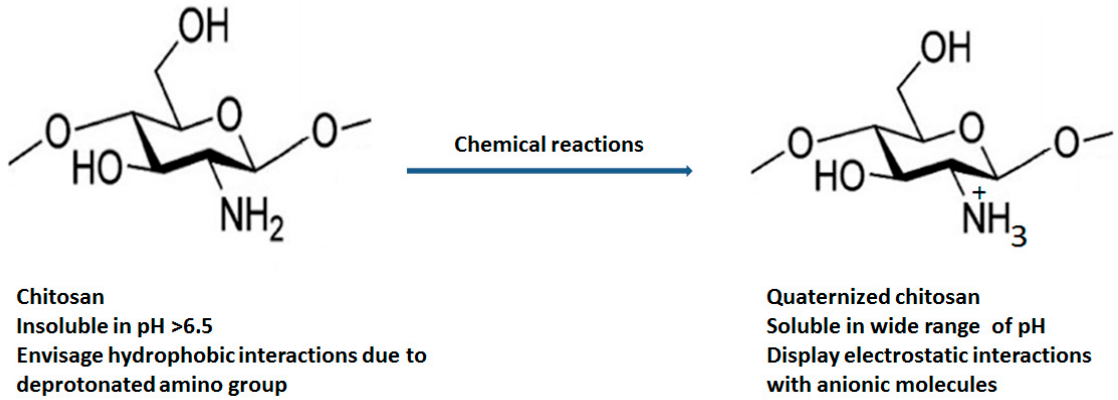
Figure 2. Structural differentiation between chitosan and quaternized chitosan.